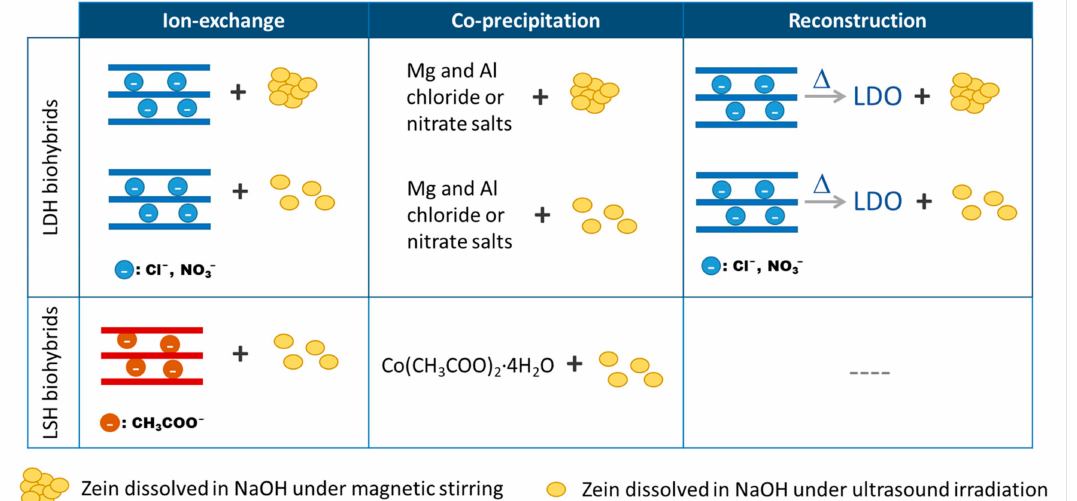
Figure 2. Schematic representation of the routes of synthesis explored in the preparation of the zein-based LDH and LSH